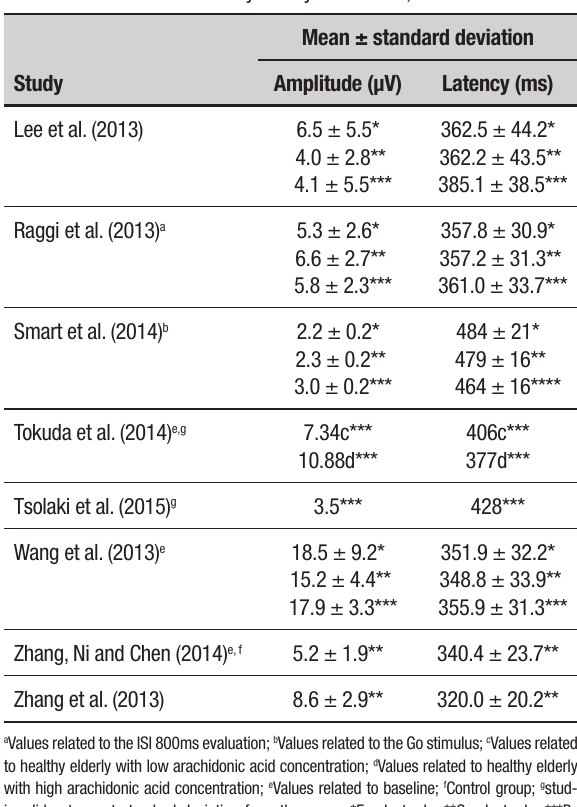
Table 2. P300 values in healthy elderly. São Carlos,